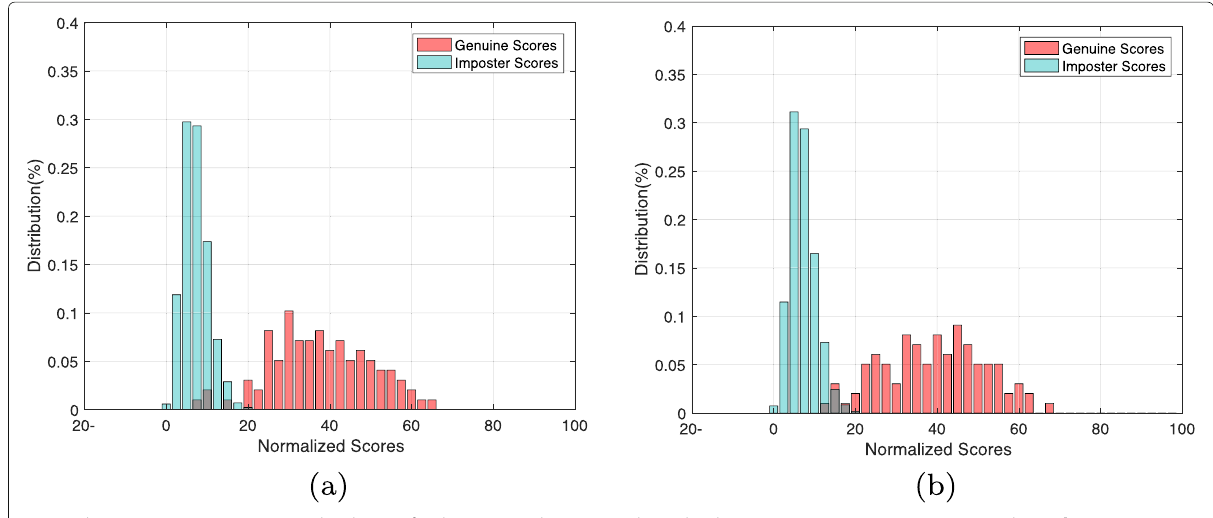
Fig. 5 The genuine-imposter scores distribution for the proposed system under stolen-key scenario on FVC 2002 DB1 ( a ) and DB2 ( b